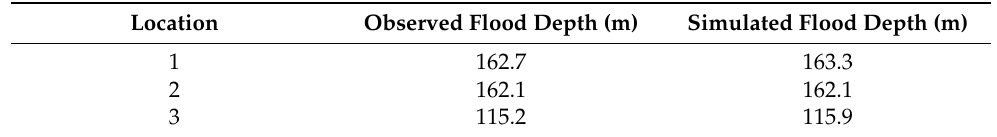
Figure 4. Location of the characteristic points to compare recorded water level from the flood event of July 2013 with the simulated water level. Table 3. Comparison of the observed flood depth from the event of July 2013 with the simulated flood depth from the proposed integrated hydrologic–hydraulic–GIS based modeling for floodplain delineation (datum NAD83CSRS 1983).